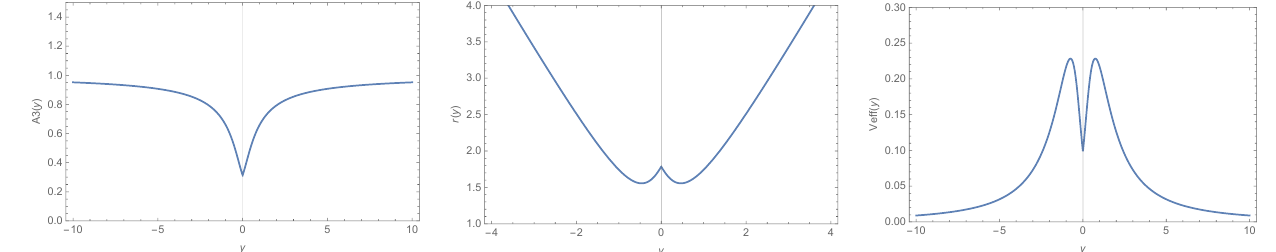
Figure 5. Plot of the function A 2 ( y ) , the radius r 2 ( y ) , and the effective potential, respectively, for the second WH solution, Equation (89). The values used for the parameters in this plot were: λ = 1, k = 3, m = 2, and L = 1.